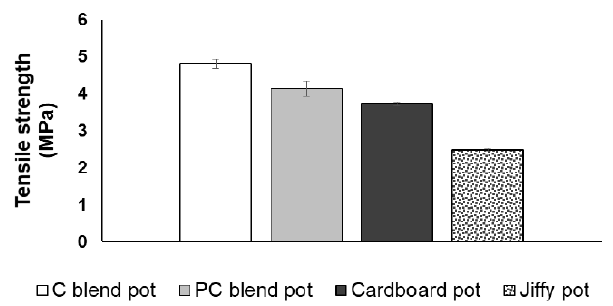
Figure 10. Bending strength of treated and untreated cotton and polycotton blends.